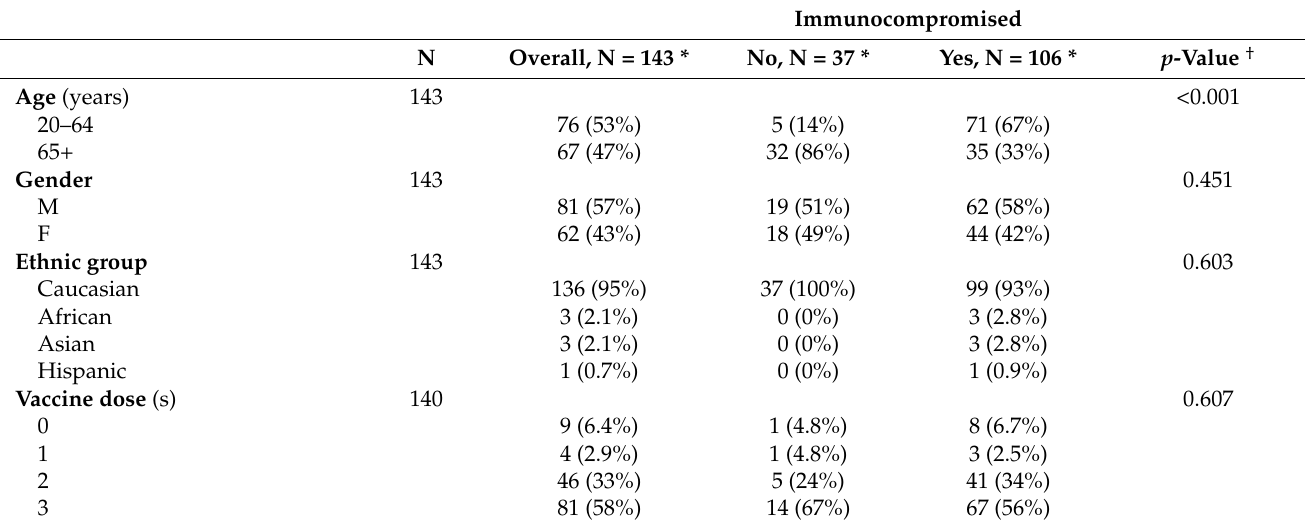
Table 1. Demographic and virologic characteristics of outpatients by subjects’ immune